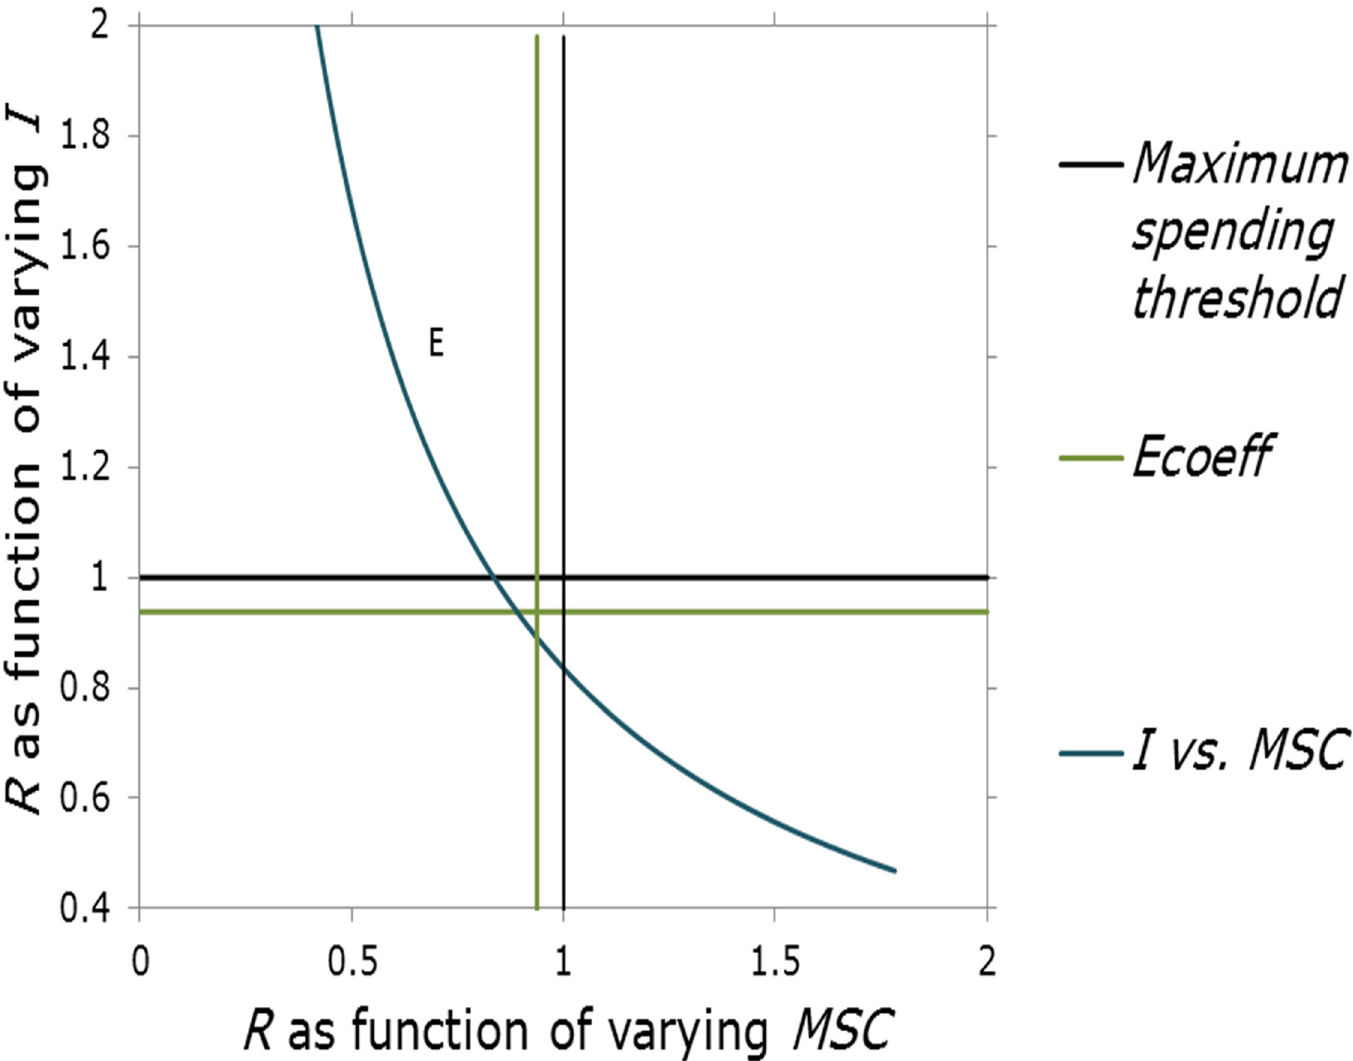
Fig 2. Rebound ratios as function of varying the initial cost ( I ) and the maximal spending capacity ( MSC ). Parameter values for vertical and horizontal curves are as in Fig